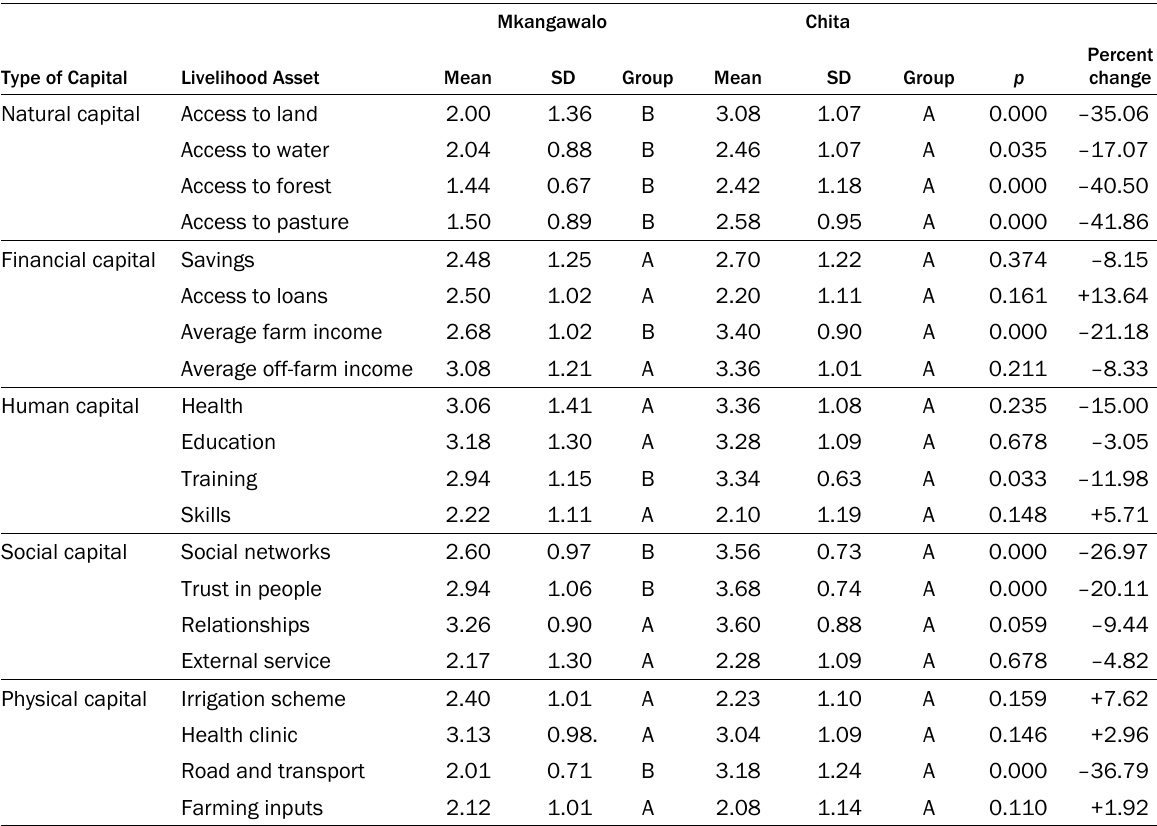
Table 2. Changes in Livelihood Assets, Comparing Affected Village (Mkangawalo) and Control Village (Chita) Before and After LaSLA Project in the Kilombero District ( n =100) Mkangawalo Chita Type of Capital Livelihood